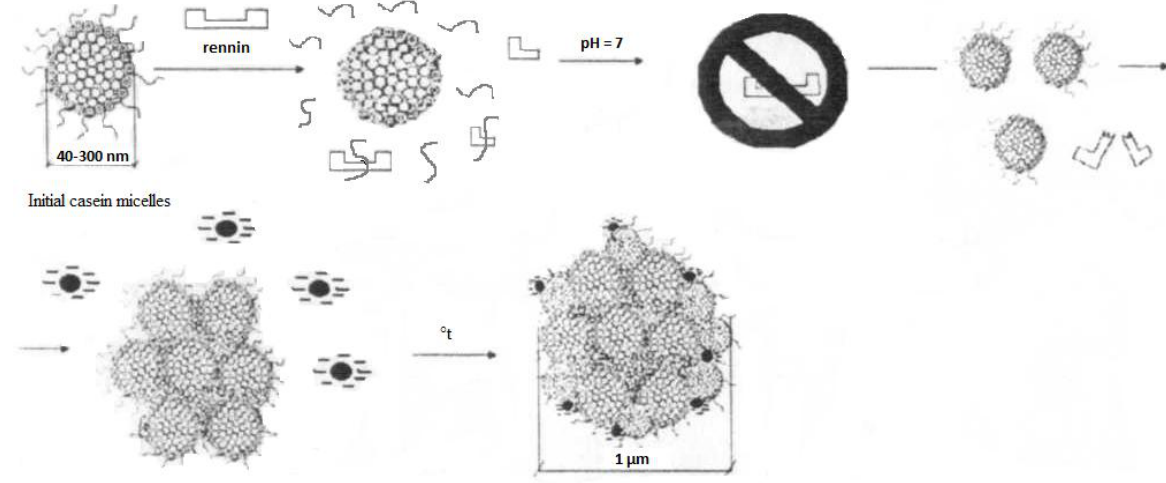
Fig. 10. Hypothetical scheme of the process of logistics of microparticulation of casein of raw milk (according to I.А. Smirnova and V.K.